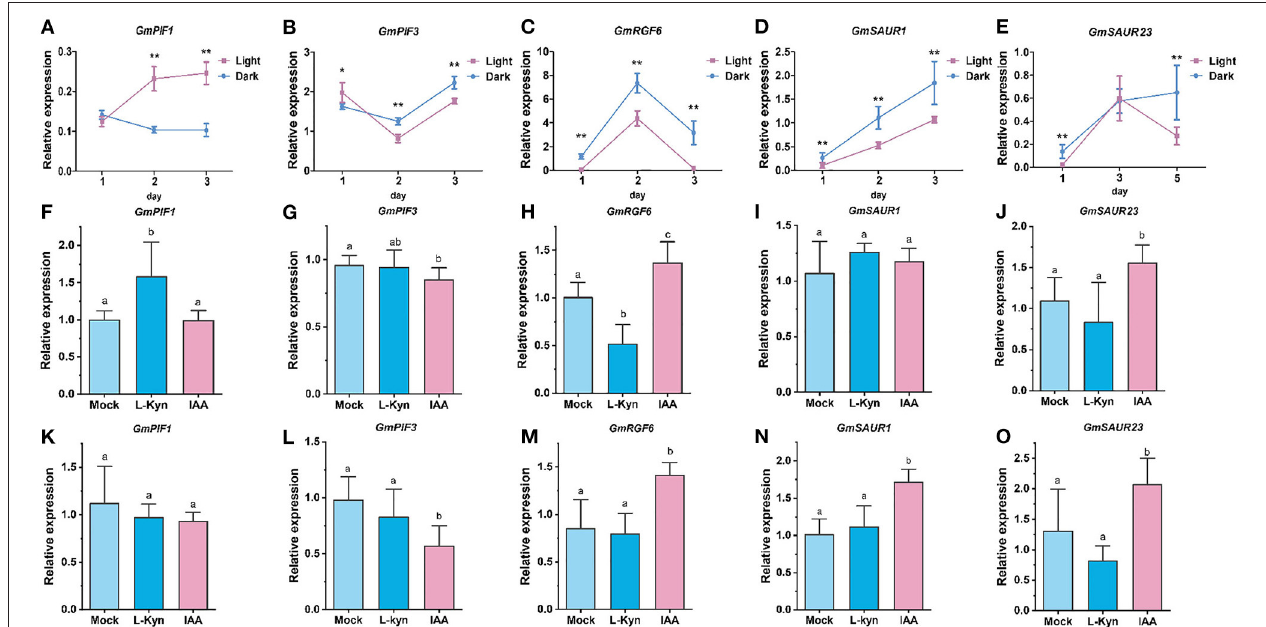
FIGURE 4 | Experssion of GmPIFs and GmSUAR s/ GmRGF6 in response to light and exogenous auxin. (A–E) GmPIFs and GmSUAR s/ GmRGF6 expression in soybean hypocotyl under light and dark condition. (F–J) GmPIFs and GmSUAR s/ GmRGF6 expression in the hypocotyl after 30min treatment of exogenous IAA and Kyn. (K–O) GmPIFs and GmSUAR s/ GmRGF6 expression in the hypocotyl after 2h treatment of exogenous IAA and Kyn. Data are presented as mean ± SD ( n = 3). A statistically significant difference of p < 0.05 or p < 0.01 relative to mock (two-tailed Student’s t -test) is denoted by * and **, respectively. Different letters (a, b) indicate significant difference (two-tailed Student’s t-